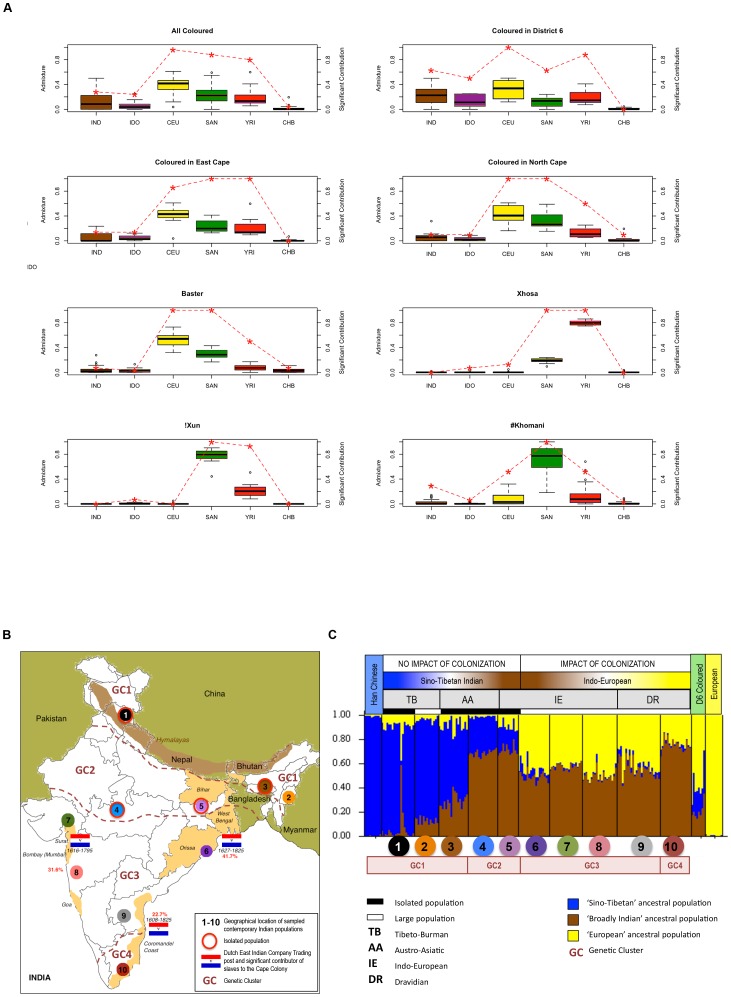
Estimation and significance of ancestral contributions to southern African populations, including further clarification of recent Asian contributions.(A) Boxplots show the estimated ancestral fractions based on ADMIXTURE analysis for six population clusters defined as IND (Indian), IDO (Indonesian), CEU (European), SAN (Ju/'hoan), YRI (Yoruba) and CHB (Han Chinese) for the !Xun, #Khomani, amaXhosa, Baster and regionally defined Coloured (3,725 markers). The red dashed line depicts significance of ancestral contributions. A value of 1.0 indicates that each individual has a significant contribution from the respective ancestral population, a value of <1 indicates that the ancestral contribution is observed only in a proportion of the individuals, while a value of 0 indicates complete absence. (B) Map of India representing the sampling sites for 10 population identifiers and four regionally relevant genetic clusters (GCs). Flags depict the geographical location and date of Dutch East Indian Company (VOC) trading posts, with percentage in red depicting the estimated slave contribution to the Cape Colony. (C) STRUCTURE analysis of 9,317 LD-pruned autosomal markers for three ancestral populations distinguishes between a ‘Sino-Tibetan’ and ‘Indo-European’ population cluster, the latter significantly impacted by colonization of India. This data suggests that both clusters contributed to slavery at the Cape.